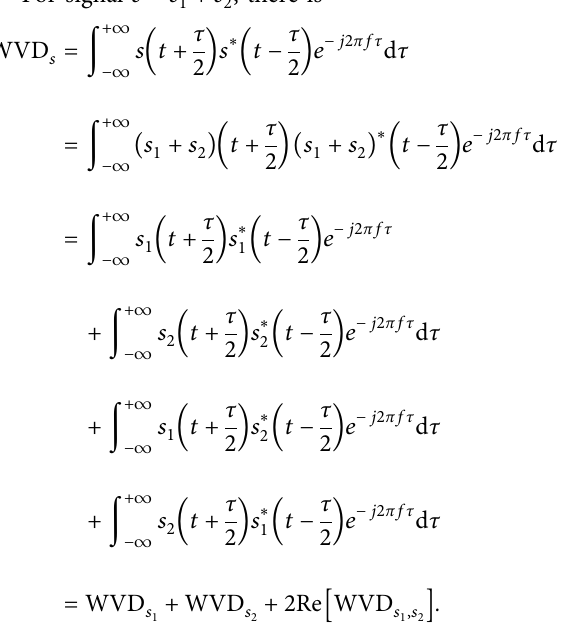
Figure 7 is the spectrogram analysis of the trombone timbre frequency signal, in which the window function is selected as the hammering window, and the length of the window is N / ( 10 + 1 )